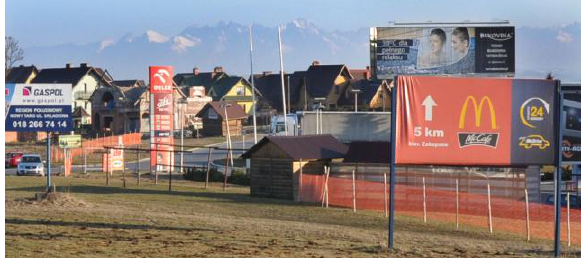
Figure 6. Advertising chaos close to Tatra Mountains in the south of